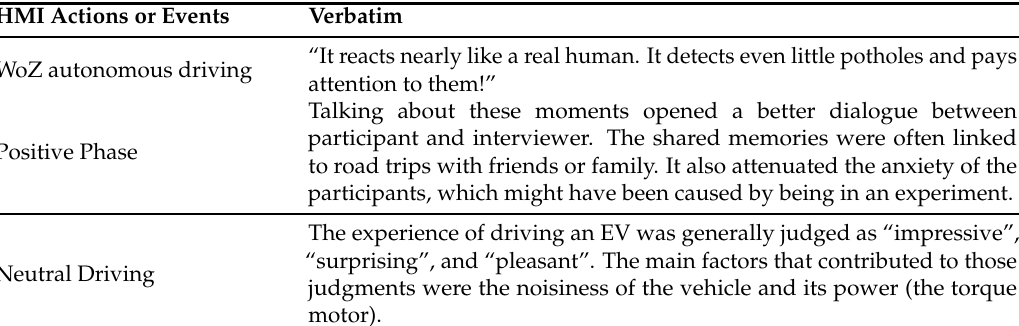
Table A1. Some verbatims pronounced during Discovery—Positive Phase.